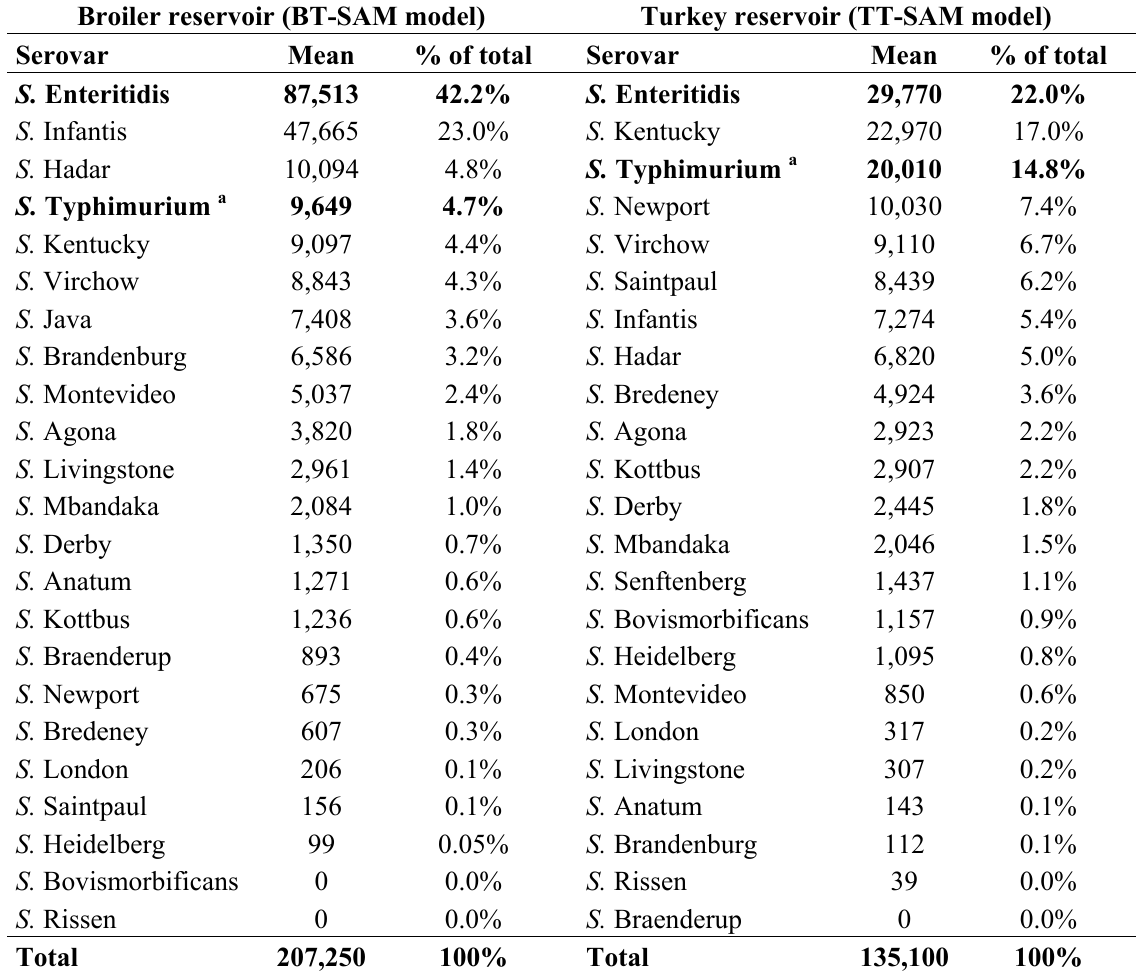
Table 4. Estimated number of human salmonellosis cases by the serovars included in the model and originating from the broiler (from BT-SAM model) [7,15] and the turkey reservoir (from TT-SAM)